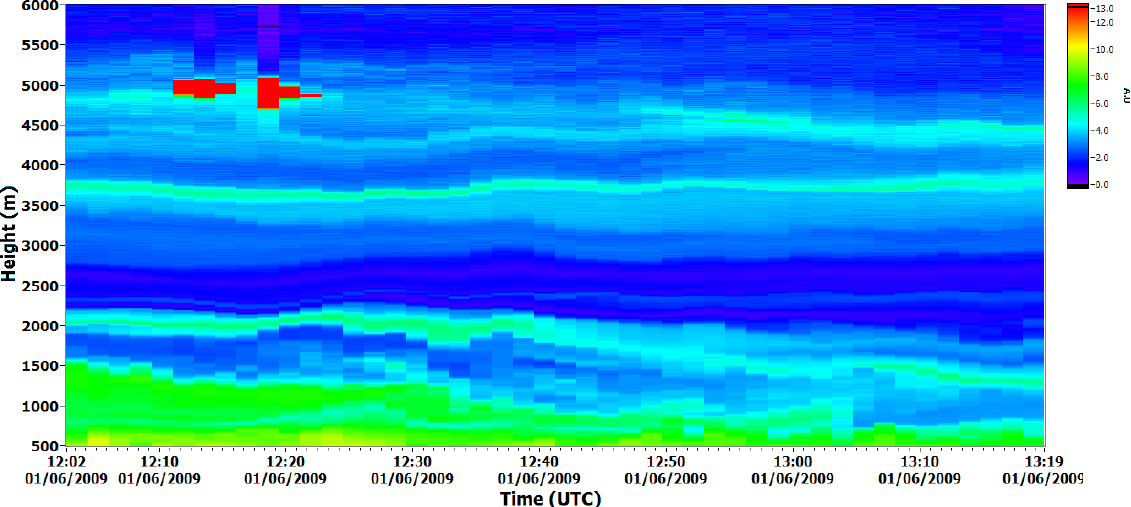
Fig. 8. Temporal evolution of the range-corrected lidar signal (in arbitrary units: A.U.) at 1064nm as obtained by the NTUA Raman lidar system on 1 June 2009 (12:02–13:19UT).